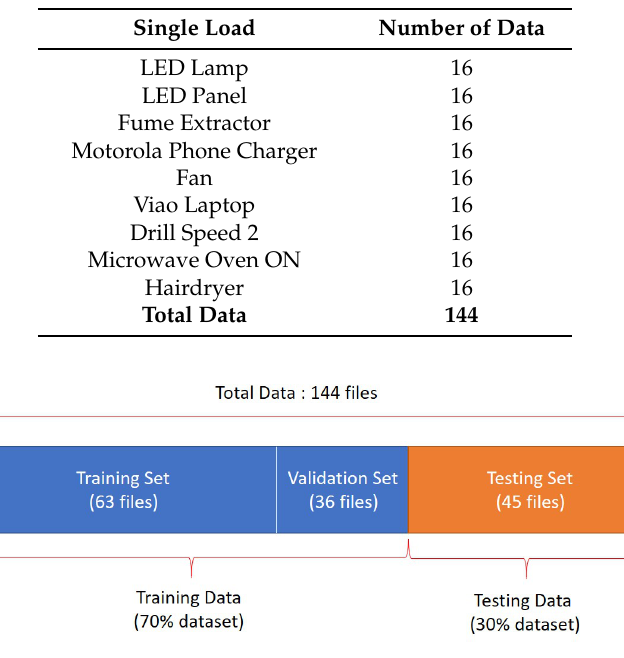
Figure 10. Illustration of splitting